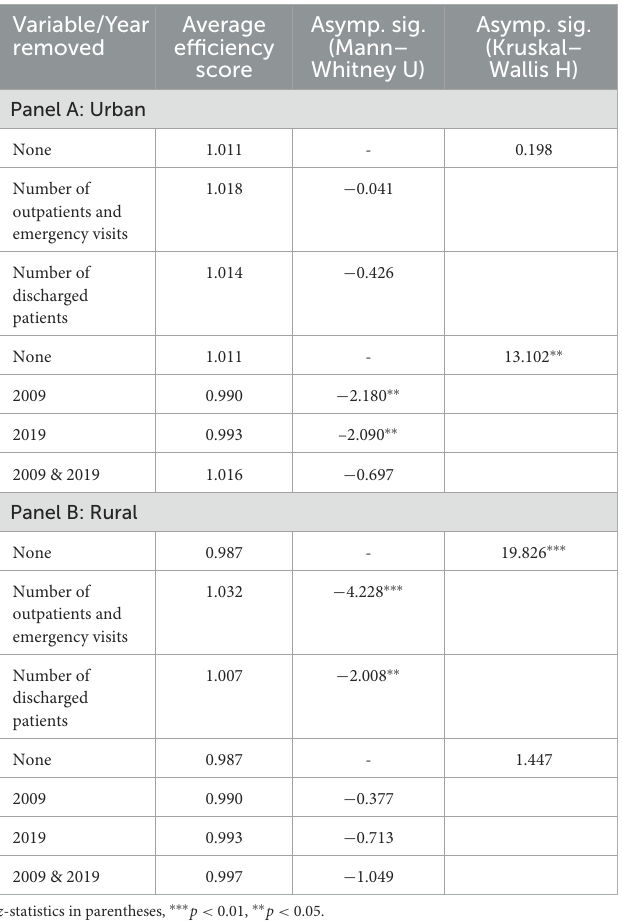
TABLE 8 Sensitivity analysis of the DEA model. TABLE 9 Sensitivity analysis of the Malmquist